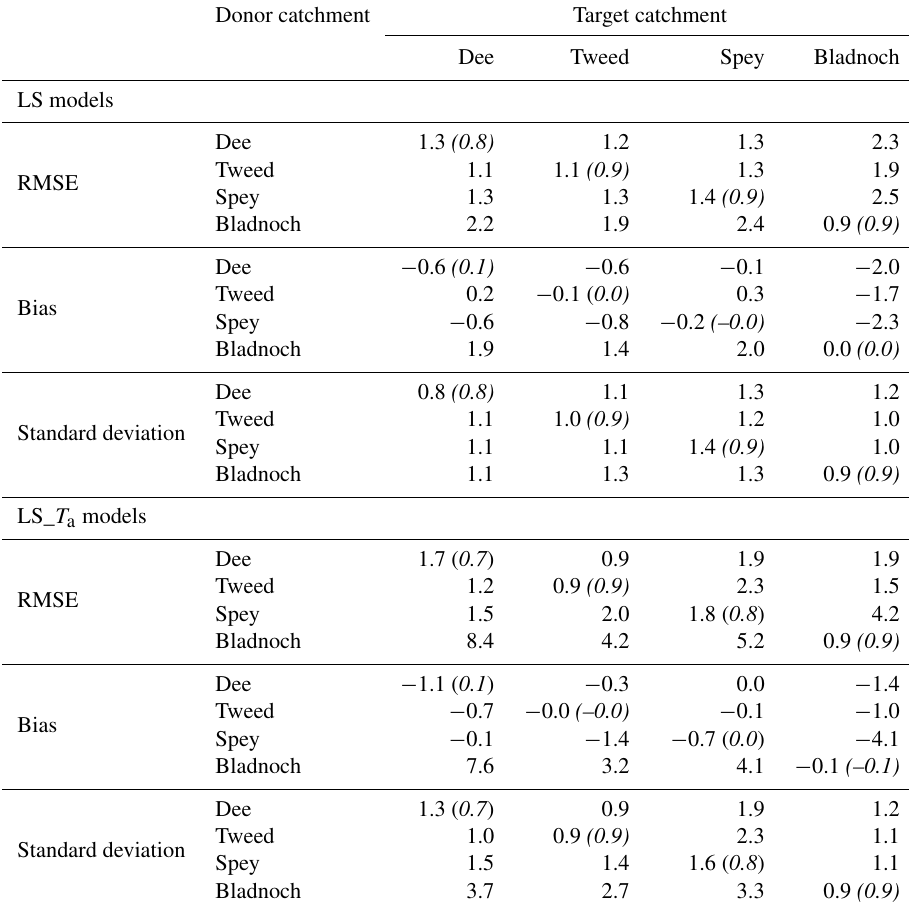
Table 3. Transferability of LS and LS_ T a models. The values in normal font are for predictions using only covariates (any RNS information is ignored). The values in italics are for predictions when the target and donor catchments are the same and all model terms are used (both covariates and the